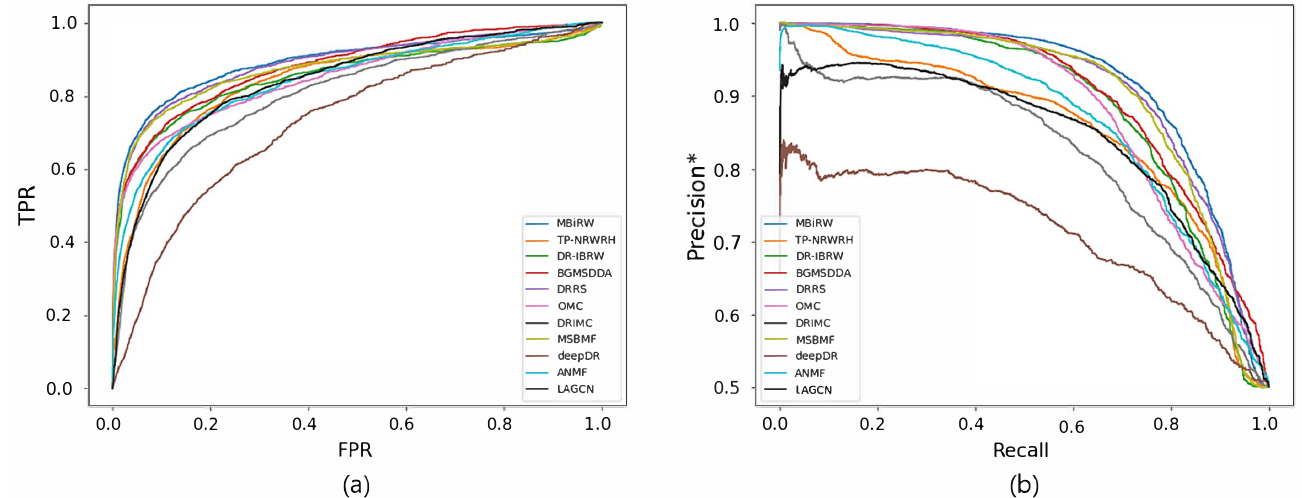
Figure 4. ROC curve ( a ) and precision*-recall curve ( b ) of drug-disease association prediction results for new drugs with network-ATC.